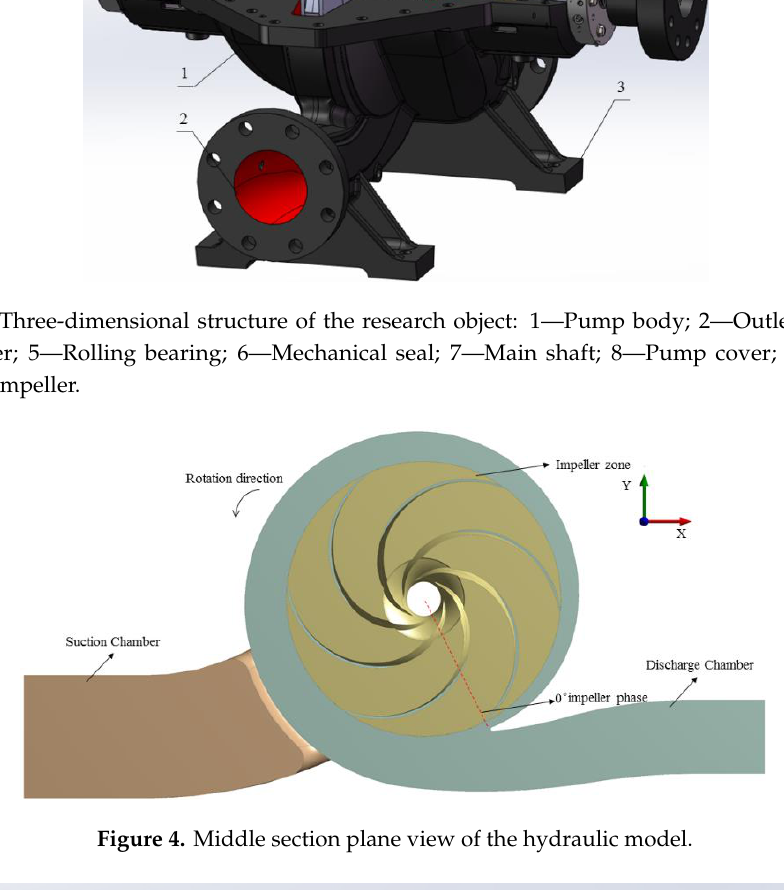
Figure 4. Middle section plane view of the hydraulic model.